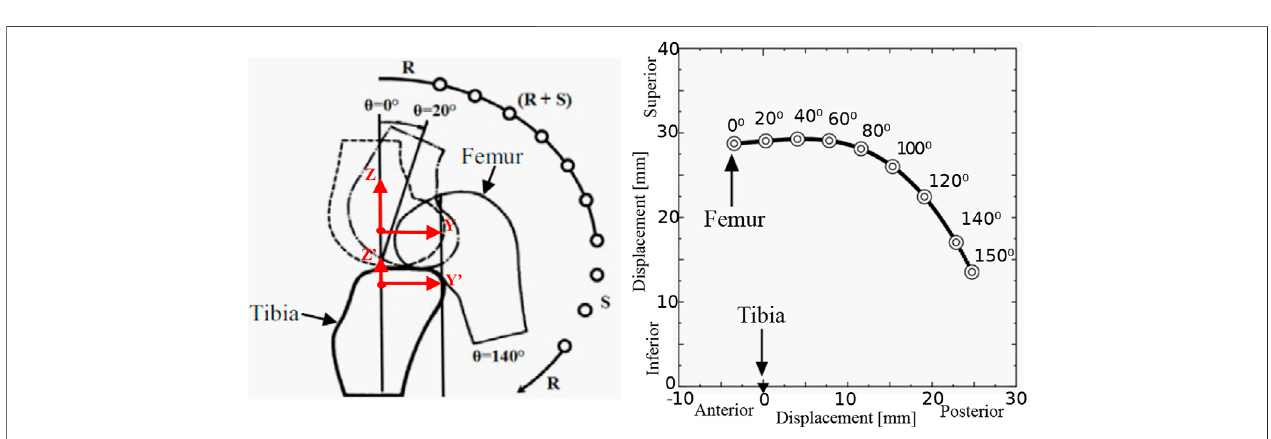
FIGURE 2 | Biomechanics of human knee joint (Fu et al., 1993; Hinson Marilyn, 1981); displacement of femur with respect to the fl exion angle of the knee.